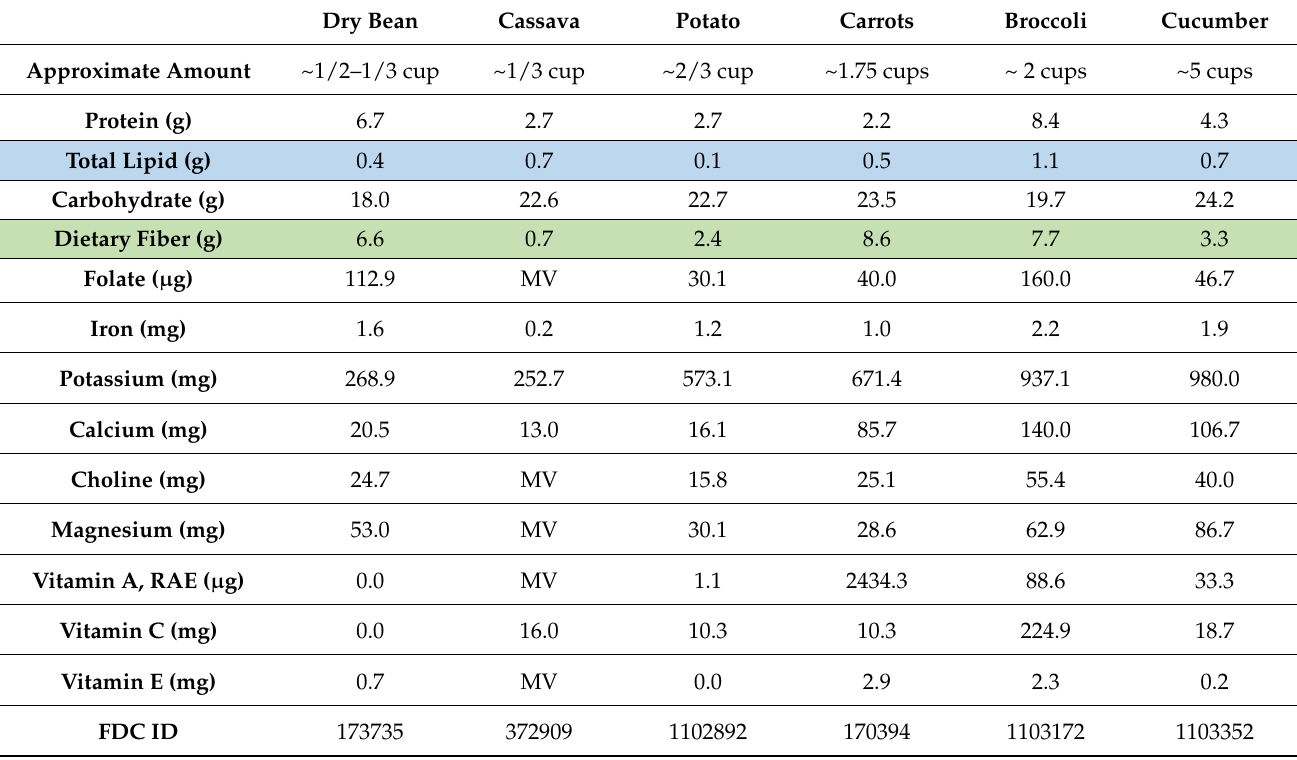
Table 2. Nutritional analysis of 100 kilocalorie portions of dry bean versus other vegetable